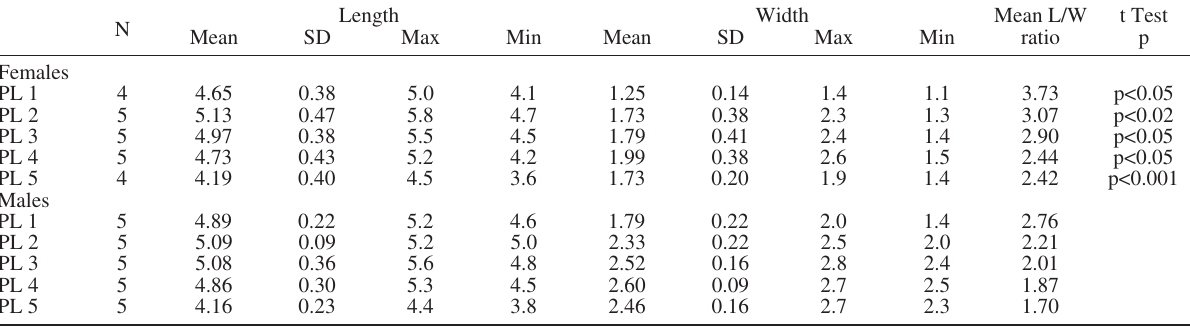
=18.8-23.5 mm) and males range